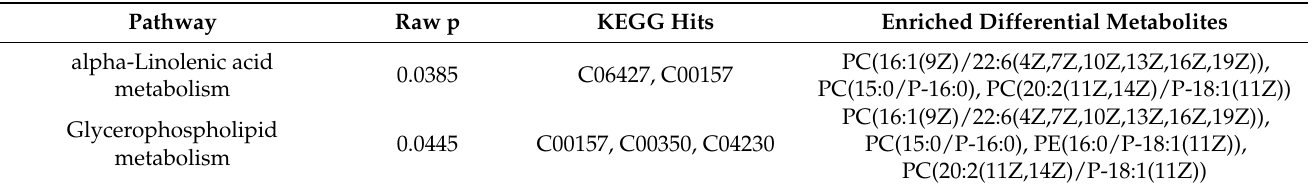
Table 2. KEGG pathway analysis of metabolites identified in positive ion mode 1 .